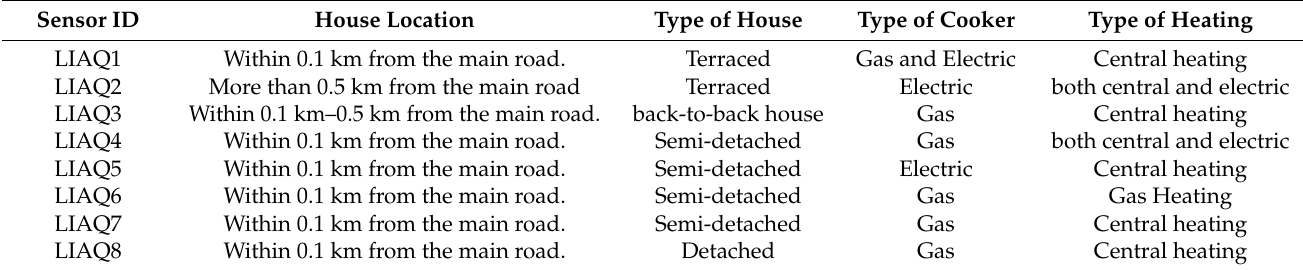
Table 6. Summary of initial questionnaires outcome of participant’s demographic information for study 2.